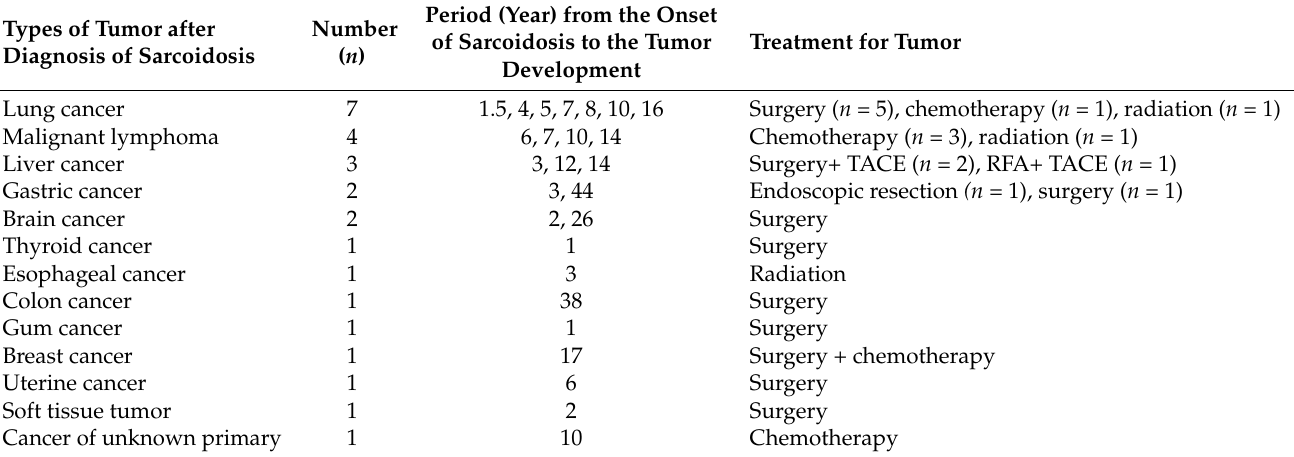
Table 1. Types of tumor after diagnosis of